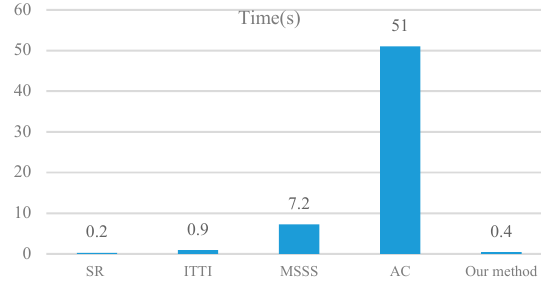
Figure 5. Algorithm processing time.